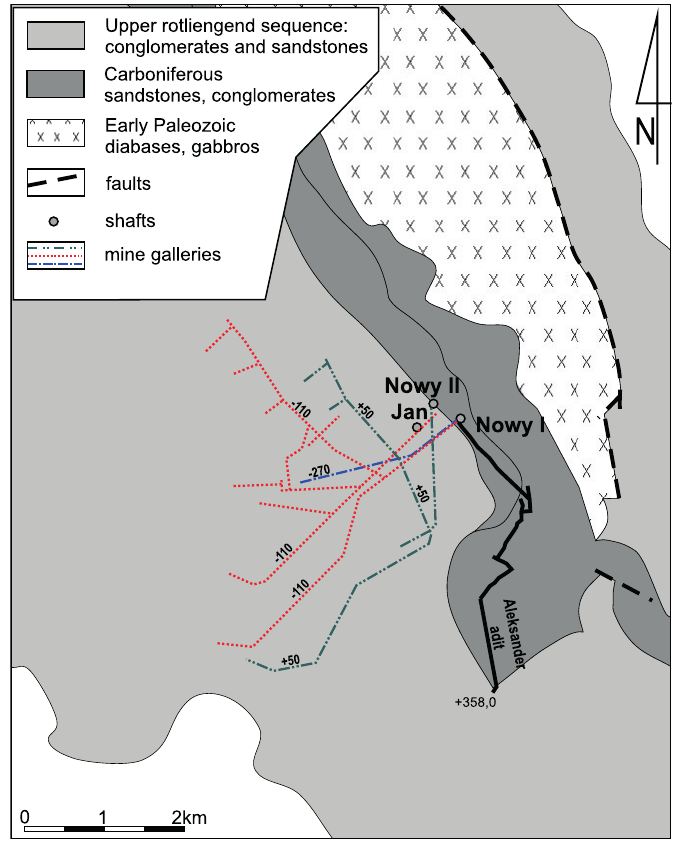
Figure 2. Scheme of excavations, by which water was delivered to the central pumping stations at levels +50 and − 110 located at the “Jan” and “Nowy I”